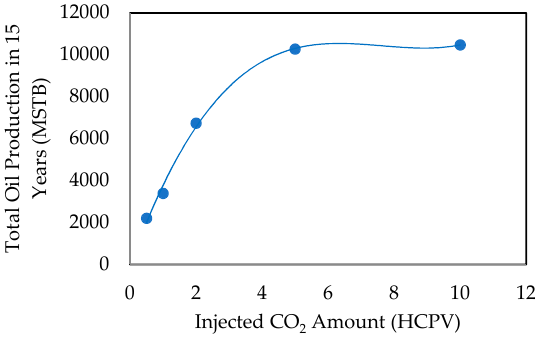
Figure 8. Variation of oil production with amount of injected CO 2 .